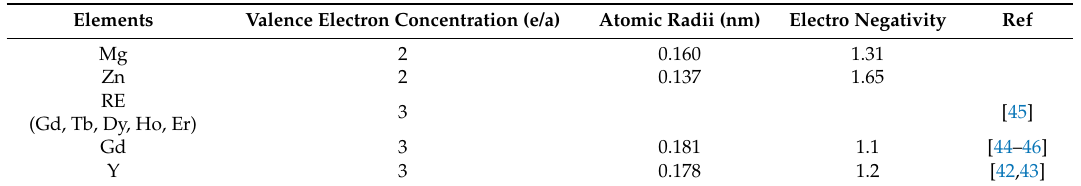
Table 6. Data of the valence electron concentration (e/a), Atomic radii (a) and Electro negativity of elements involved in